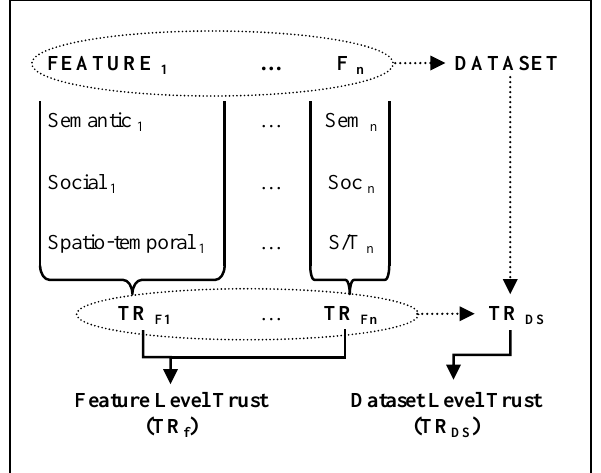
Figure 2. Formation of trust ratings corresponding to feature (TR F ) and dataset (TR DS ) levels; in the same manner as a dataset is an accumulation of features a datasets trust rating is an aggregate of feature trust